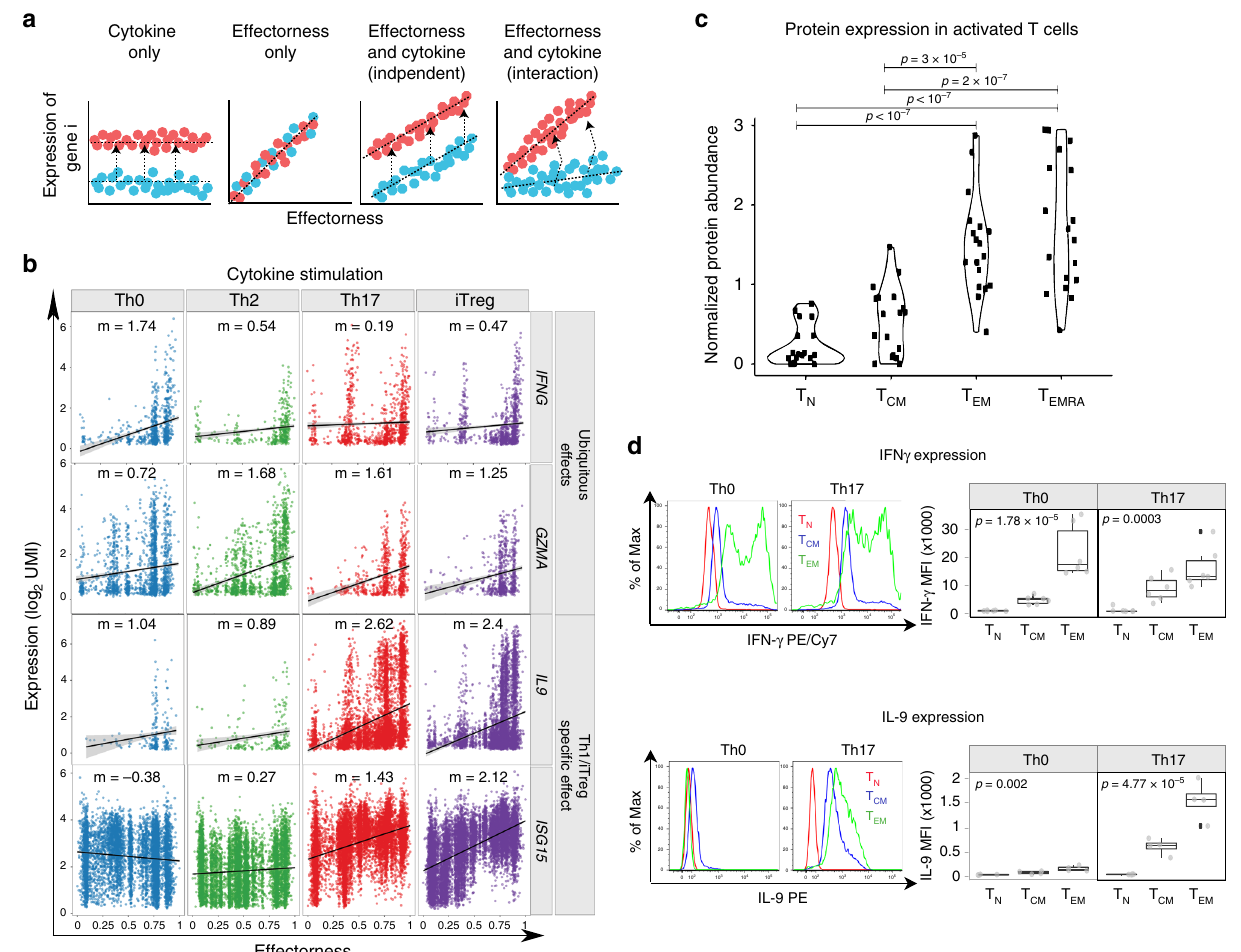
Fig. 6 Interactions between effectorness and cytokine condition regulate gene expression. a Schematic representation of the gene expression interaction model. Effectorness and cytokine conditions were incorporated into a linear model with an interaction term (Methods). Genes were assigned to four groups: genes induced by cytokine-stimulation regardless of effectorness (left panel), genes which correlate with effectorness regardless of cytokine- stimulation (central left panel), and genes which correlate with both effectorness and cytokine-stimulation either independently (central right panel) or through an interaction (right panel). b Plots of gene expression ( y axis) as a function of effectorness ( x axis), with cells strati fi ed by cytokine condition. Two example genes signi fi cantly associated with effectorness regardless of cytokine conditions (top panels) and two example genes with a strong interaction between effectorness and Th17 or iTreg-stimulation (bottom panels). Each dot represents a single-cell. c Protein expression levels for 18 genes associated with effectorness in activated T N , T CM , and T EM and T EMRA cells regardless of cytokines condition (genes used in the analysis: ACTB, CCL3, CCL5, CTSW, GNLY, GZMA, GZMB, HLA-DPB1, HLA-DQA1, HLA-DRA, HLA-DRB1, HOPX, IFNG, LGMN, LMNA, NFKBIA, TMEM173, TNFRSF18 )). Expression values were obtained from a publicly available quantitative proteomics data set (Methods). Signi fi cance was calculated using one-way ANOVA ( p = 3.42 × 10 − 12 ) and group means were compared using Tukey ’ s Honest Signi fi cant Difference test. Only signi fi cant p -values are shown ( p < 0.05). Each dot represents an individual gene ( n = 18). d Levels of IFN γ and IL-9 protein in Th0 and Th17-stimulated T N , T CM , and T EM cells as assessed by fl ow cytometry. Representative cytometry histograms of IFN γ and IL-9 expression (left panels) and mean fl uorescence intensity (MFI) of cytokine-expressing cells (right panels). P -values were calculated using one-way ANOVA. Each dot represents a biologically independent sample. Number of samples: 6 (IFN γ ) and 4 (IL- 9). Boxplot centers represent median values, while the boxplot bounds represent the 25% and 75% quantiles. Boxplot whiskers represent the